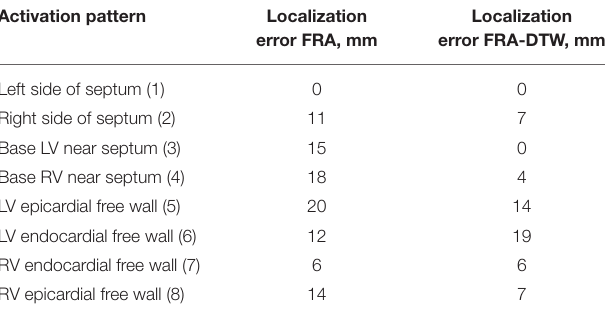
TABLE 1 | Localization error for the realistic ectopic